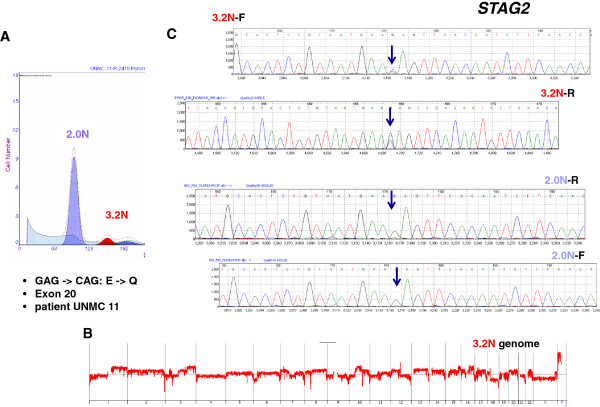
Somatic mutation of STAG2 in metastatic PDA. (A) Flow cytometry analysis and sorting of a 3.2 N aneuploid population in primary pancreas tissue from rapid autopsy specimen UNMC 11R. (B) Whole genome aCGH plot of the 3.2 N population. (C) Detection of somatic mutation in forward (3.2 N-F) and reverse (3.2 N-R) sequences in the 3.2 N genome. Mutation was not detected in the matching 2.0 N population sorted from the same tissue.